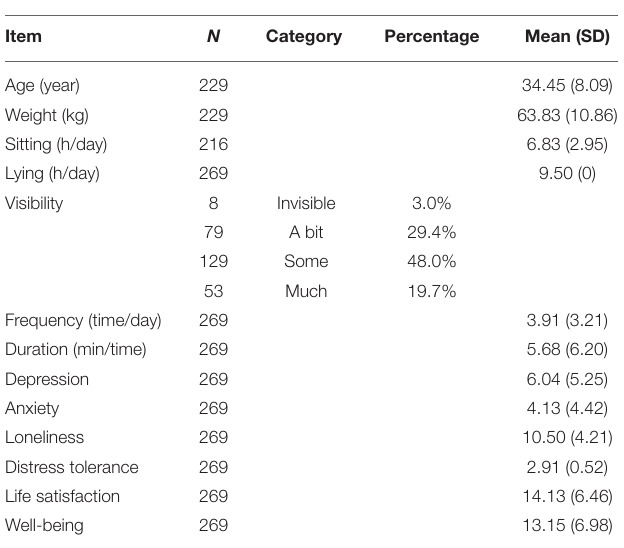
TABLE 4 | Prisoners’